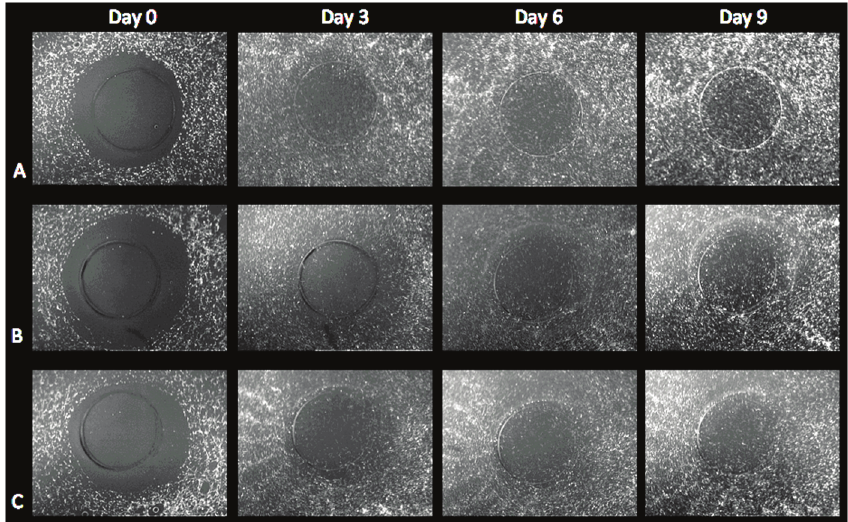
Figure 4. Three-dimensional wound migration assay. Fibroblast migration from collagen to a collagen defect with ( A ) control medium, ( B ) conditioned medium from a scratched 2D layer of HFFs, or ( C ) conditioned medium from a non-scratch confluent 2D layer of HFFs. Migration measured using ImageJ as distance from wound edge to edge of migrated